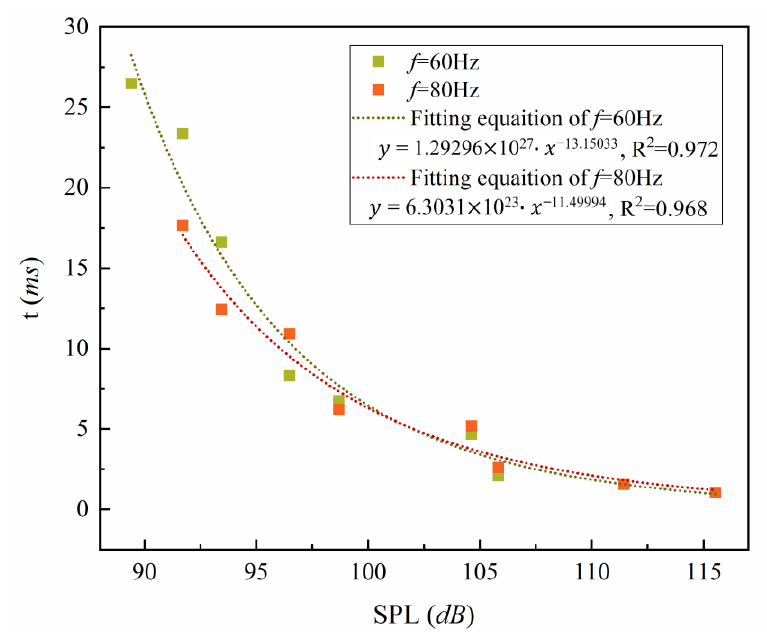
Figure 12. Average agglomeration time of particles under sound waves of different SPL.